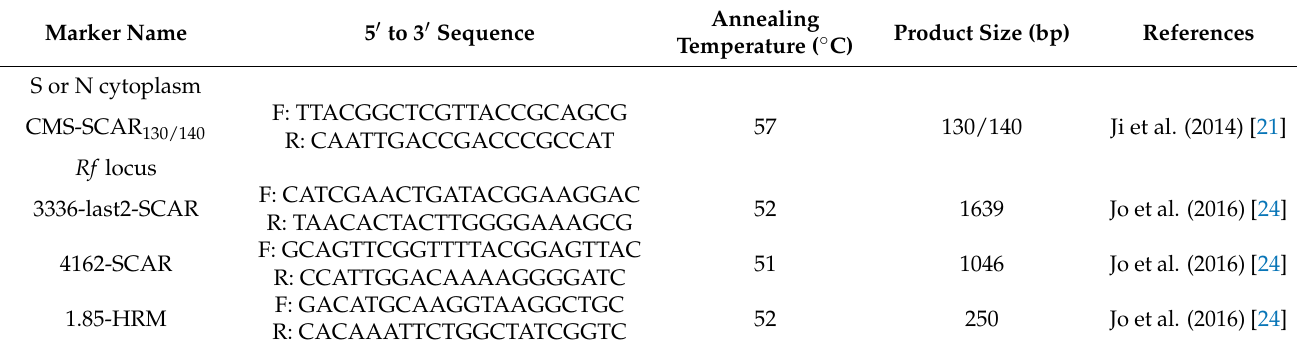
Table 2. List of markers in this